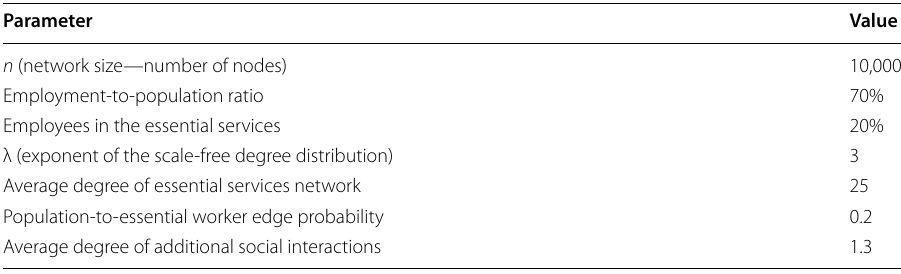
Most of these parameters are an estimation from various sources to reflect the US population pre‑pandemic. The network size of 10,000, while clearly more representative of a small town than of a country, allows computationally efficient simulation and rich outcomes of the disease spread. The parameters can be changed in the code (see “Methods” section)